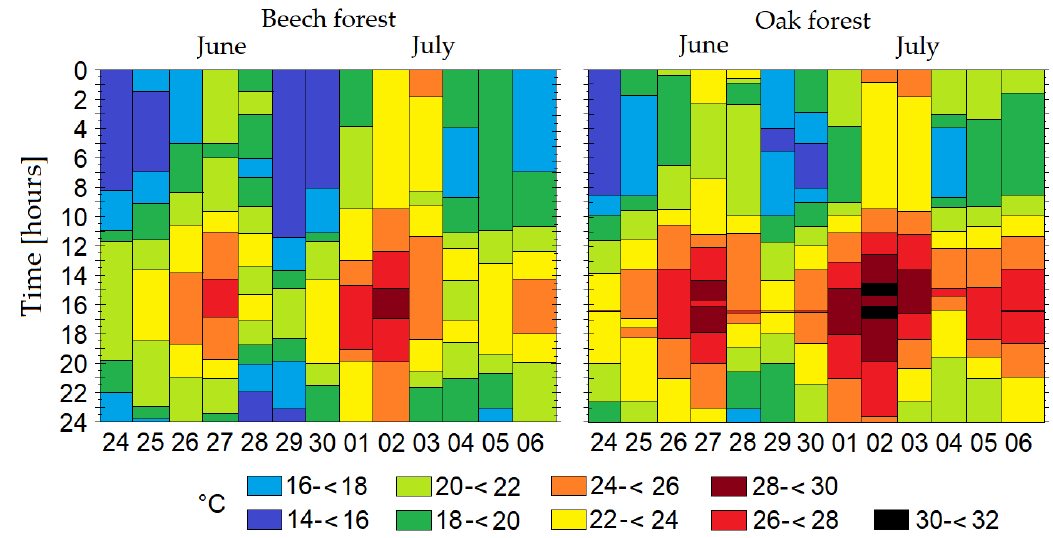
Figure 4. Diurnal variation in air temperature on 13 days in summer 2019 (June 24—July 06) in the interior of the beech forest ( left ) and oak forest ( right ) of the Eşelniţa transect.